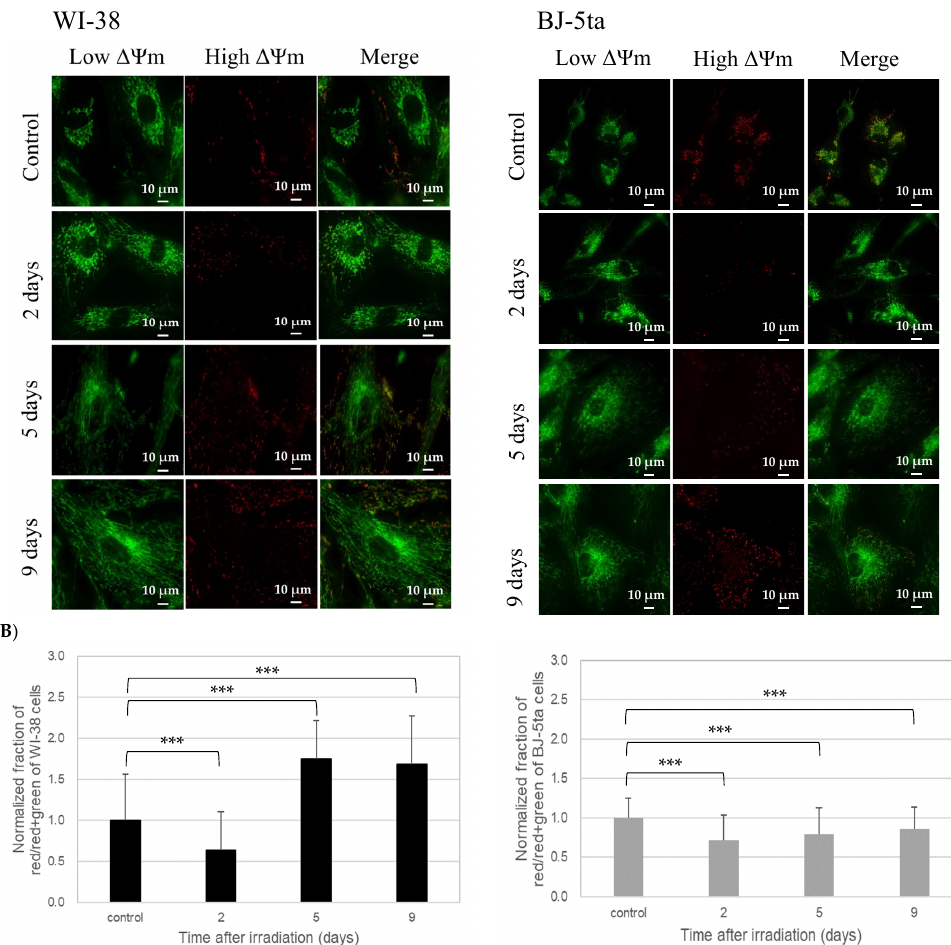
Figure 5. ( A ) Representative images of the low and high ΔΨ m regions with JC ‐ 1 staining of nonir ‐ radiated (control) and 20 Gy X ‐ irradiated WI ‐ 38 and BJ ‐ 5ta cells observed under a fluorescence mi ‐ croscope at 60× magnification. The images of the irradiated cells were taken at 2, 5, and 9 days after irradiation. ( B ) Fraction of the high ΔΨ m area defined as the ratio of the red area to the sum of the red and green areas. All values were normalized by the control cells, and the error bars represent the standard deviation ( n = 90). Statistical analysis was performed with one ‐ way ANOVA ( p < 0.001) plus a Student’s t ‐ test. The symbol * indicates the p ‐ values of the t ‐ test compared with the control and irradiated samples, respectively; *** p < 0.001. 3. Discussion The irreversible cell ‐ cycle ‐ arrested cells used in this study shared many characteris ‐ tics with senescent cells [31], such as the permanent loss of proliferative potential